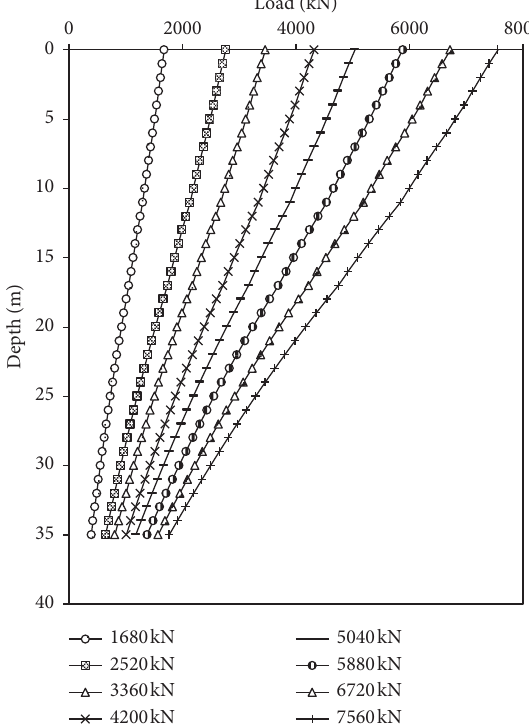
Figure 25: Load transfer along the pile